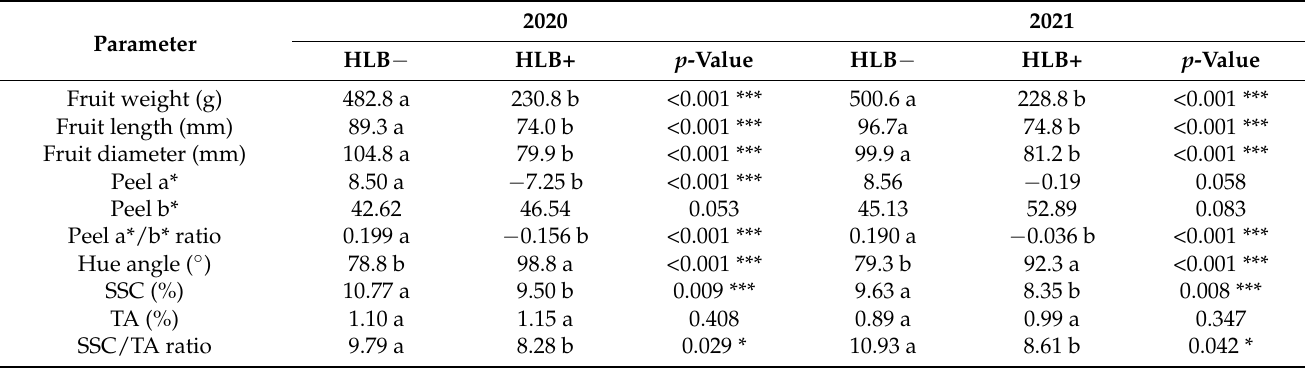
Table 1. Quality attributes of ‘Ray Ruby’ grapefruit and juice of healthy (HLB − ) and HLB-affected (HLB+) fruits of two harvest seasons, 2020 and